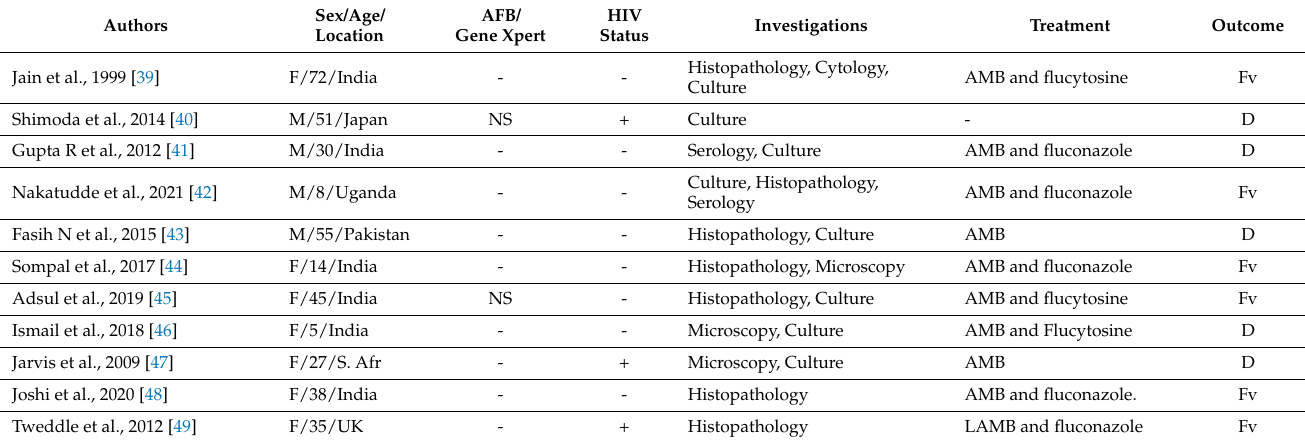
Table 5. Cases of Cryptococcosis misdiagnosed as